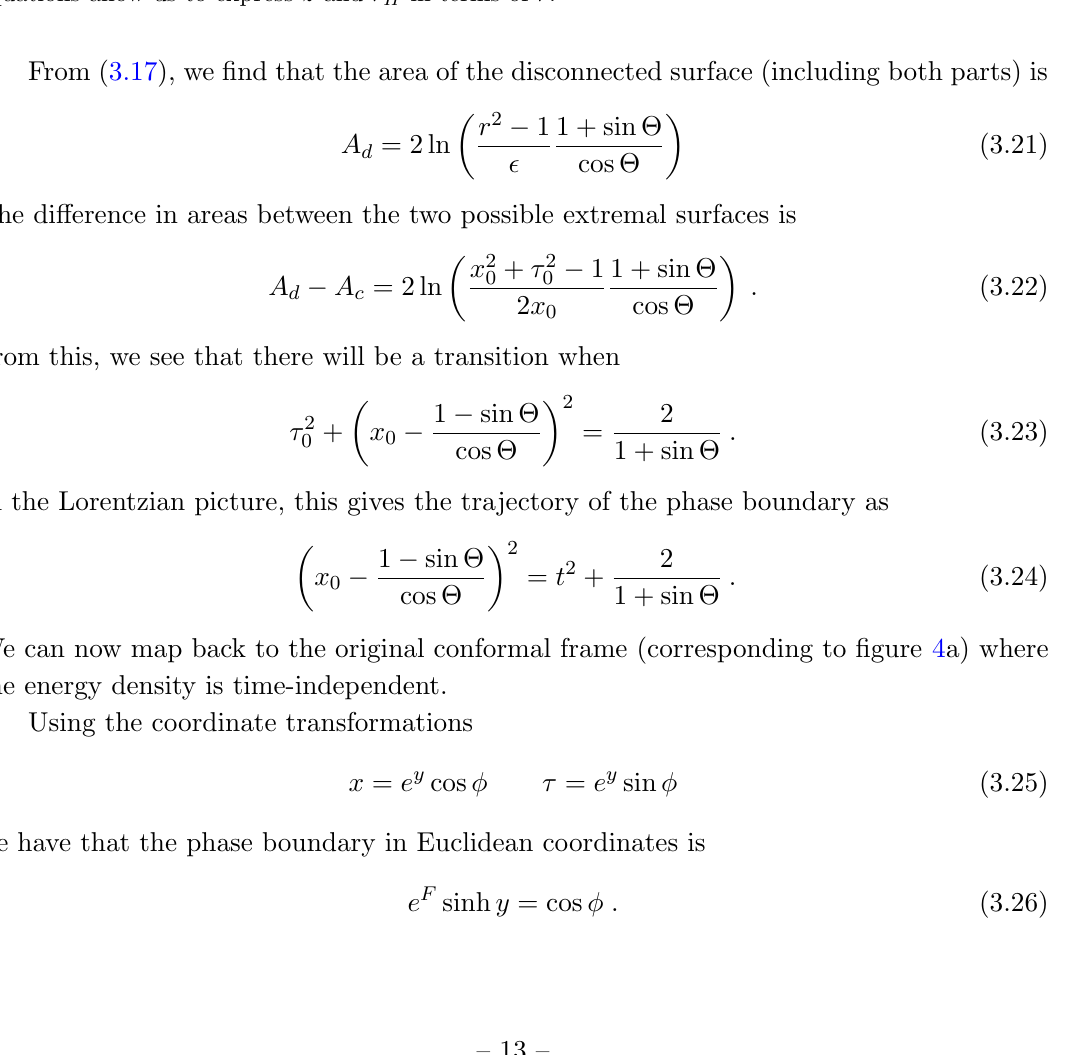
Figure 5 . Geometry of the ETW brane and half of the disconnected RT surface in the plane of the RT surface. We have OQ = 1 and OA = tan (cid:2). Thus, AQ = AH = sec (cid:2). Also HB ? AH so AH 2 + HB 2 = OA 2 + OB 2 . This gives r H = ( r 2 (cid:0) 1) = (2 r ). Now OM = OA tan (cid:11) = tan (cid:2) tan (cid:11) and AM = OA sec (cid:11) = tan (cid:2) sec (cid:11) . So HM = HA (cid:0) MA = sec (cid:2) (cid:0) tan (cid:2) sec (cid:11) . Finally, HM=HB = tan (cid:11) gives r H = sec (cid:2) cot (cid:11) (cid:0) tan (cid:2) csc (cid:11) , while HP = HB sin (cid:11) gives z = r H sin (cid:11) . The boldface equations allow us to express z and r H in terms of r